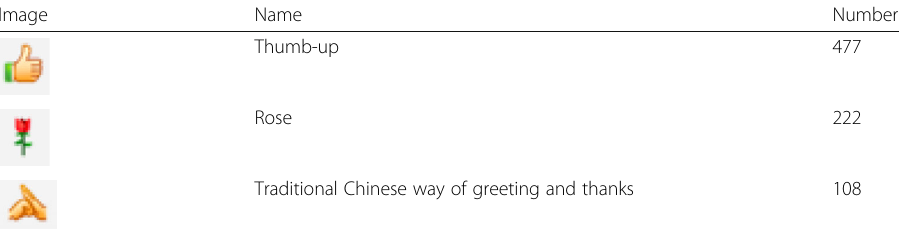
Table 2 Top 3 most frequent Emojis